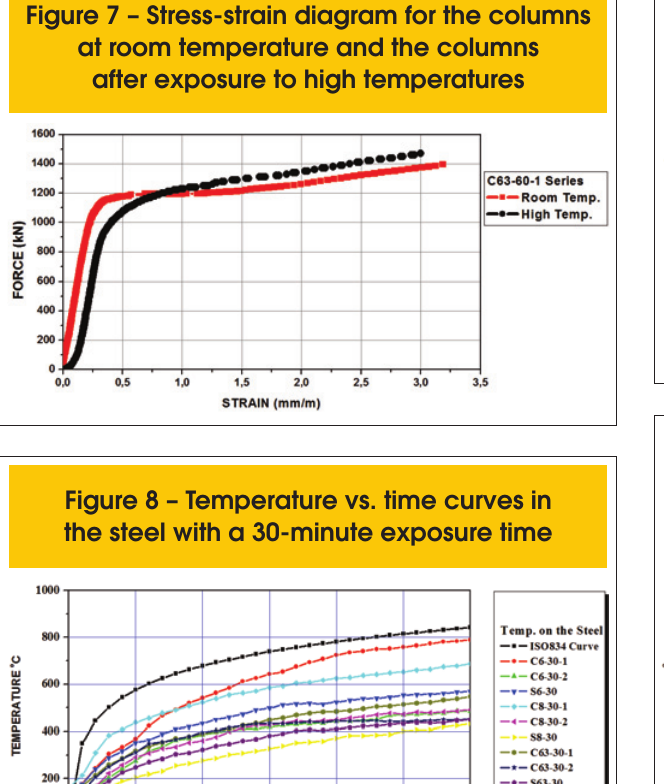
Figure 9 – Temperature vs. time curves at the steel-concrete interface with a 30-minute exposure time